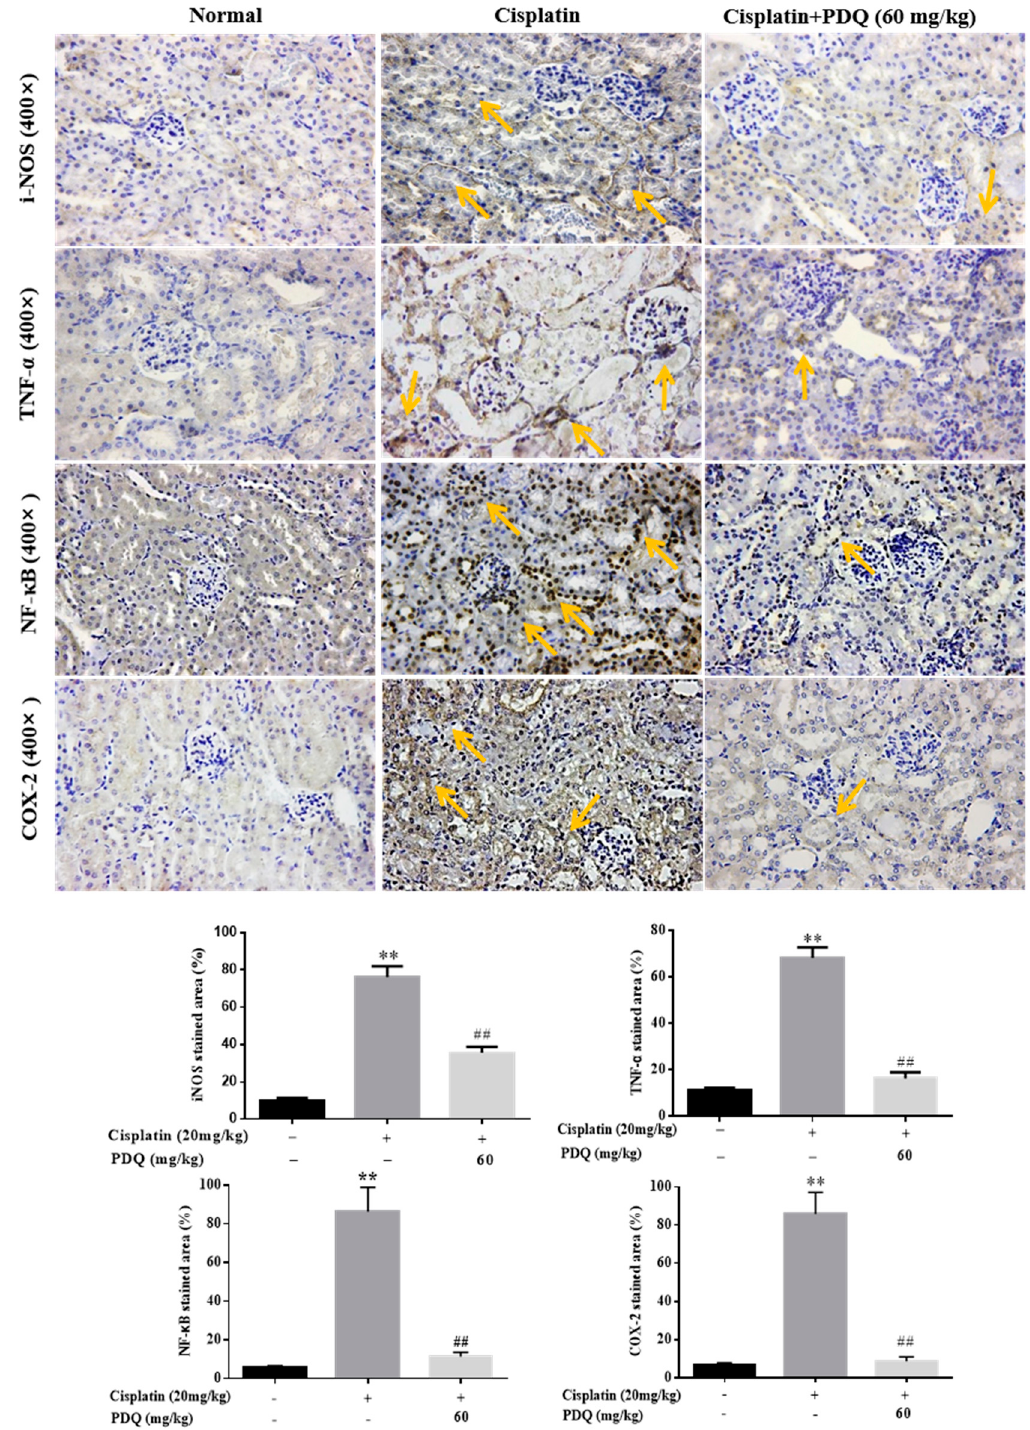
Figure 9. Effects of PDQ on the expression of inducible nitric oxide synthase (i-NOS), TNF- α , NF- κ B, and cyclooxygenase-2 (COX-2); (400 × ). Protein expression was examined by immunohistochemistry; arrows show positive protein expression in renal tubular epithelial cells. n = 8, ** p < 0.01 vs. control group; ## p < 0.01 vs. cisplatin group.